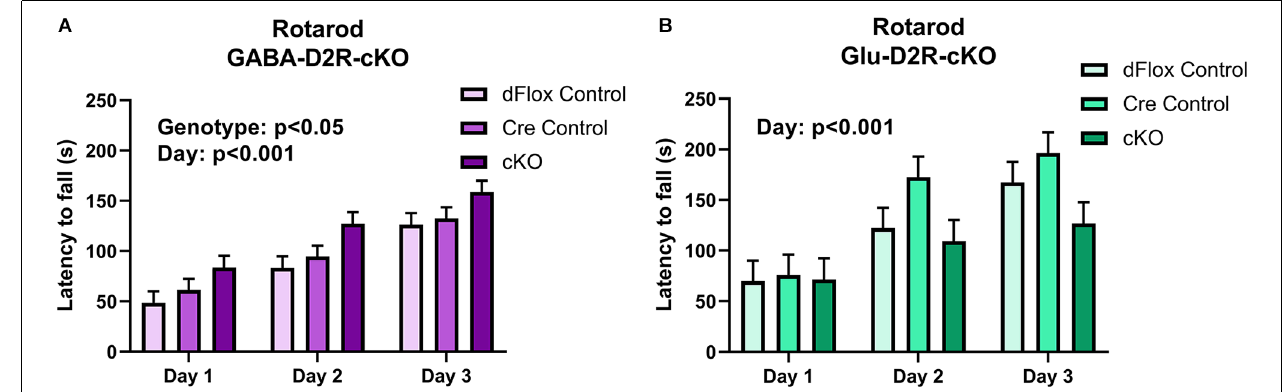
FIGURE 10 | Changes in motor coordination in GABA-D2R-cKO mice. While performance on the rotarod improved over time in both the GABA-D2R-cKO (A) and the Glu-D2R-cKO (B) lines, only mice with decreased D2Rs in cortical interneurons performed significantly better than its respective controls. N = 8/group for Glu-D2R-cKO mice and 25–26/ for GABA-D2R-cKO (several cohorts were run to confirm the